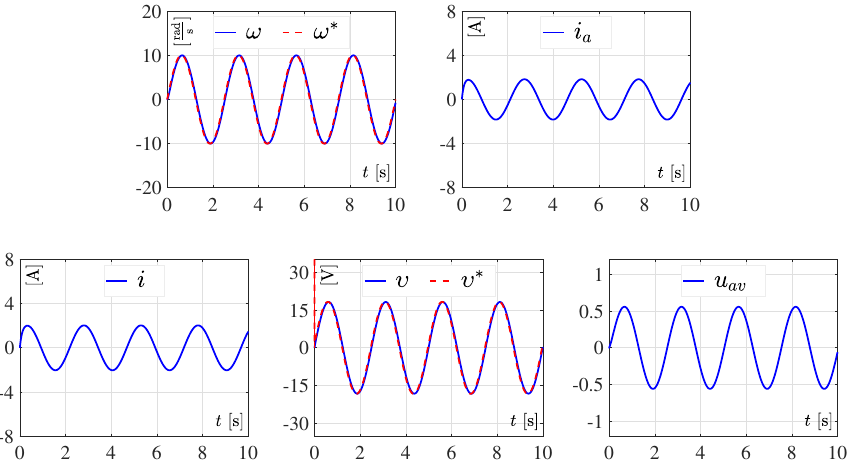
Figure 8. Simulation results when the second desired angular velocity profile, given by (23), is contemplated for the system in